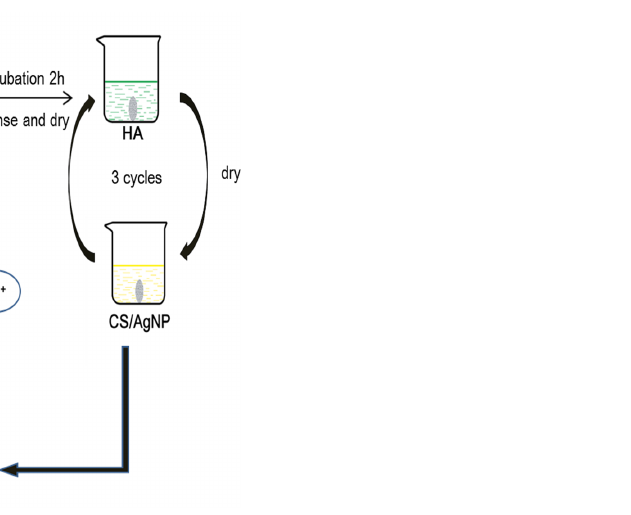
Fig 1. Schematic diagram: the process of fabricating the multilayer coatings on the PTL-primed Ti surface and the mechanism of antibacterial ability of this sample under aqueous conditions. As water contacts the surface, the nanoparticles are oxidized to release Ag +